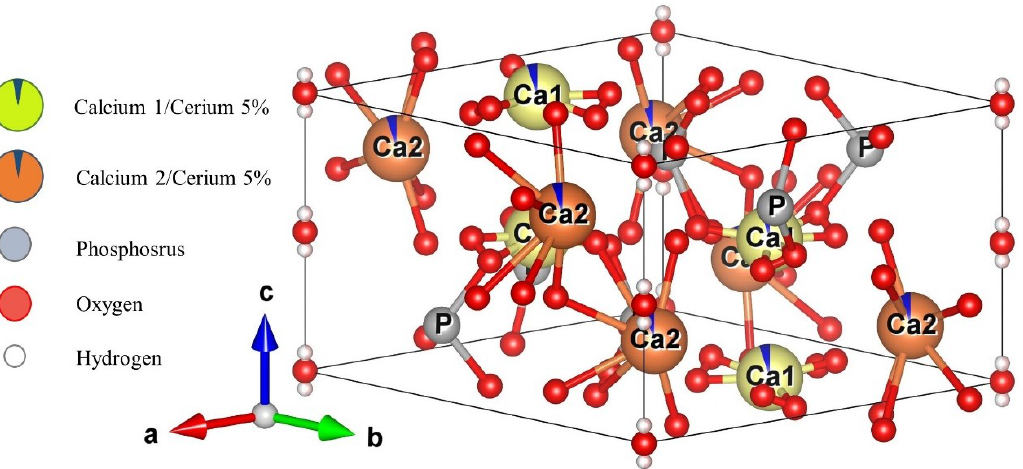
Figure 4. Simulated representation of the Ce-Hap unit cell of that composes S HG .